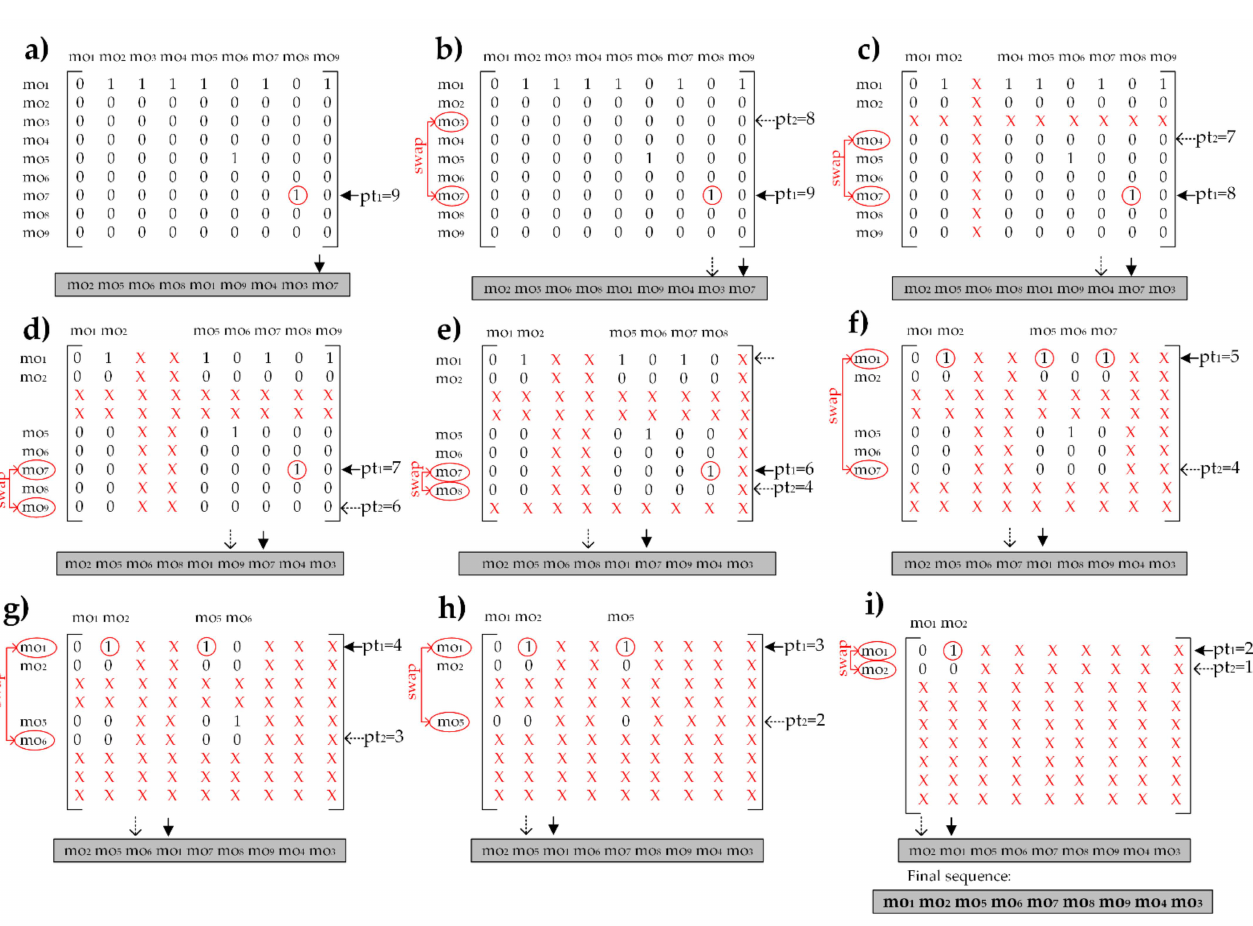
Figure 8. The step-by-step procedure of the constraint handling heuristic: ( a ) Select the pointer identifying the last machining operation in the sequence, mo 7 ; ( b ) Swap mo 7 and mo 3 according to the condition in Step 5.II; ( c ) Exclude row and column of mo 3 , and select the next one, mo 4 ; ( d ) Swap mo 7 and mo 4 according to the Step 5.II, exclude row and column of mo 4 , and select the next operation, mo 9 ; ( e ) Swap positions of mo 7 and mo 9 , exclude row and column of mo 9 , and select the next operation, mo 8 ; mo 1 is skipped according to the Step 5.II.f); ( f ) Swap positions of mo 7 and mo 8 , exclude row and column of mo 8 , and select the next operation, mo 1 ; ( g ) Swap positions of mo 7 and mo 1 , exclude row and column of mo 7 , and select the next operations, mo 1 and mo 6 ; ( h ) Leave mo 6 and mo 1 as positioned, exclude row and column of mo 6 , and select the next operation, mo 5 ; ( i ) mo 1 goes before mo 5 and before the last operation mo 2 ; the final sequence is